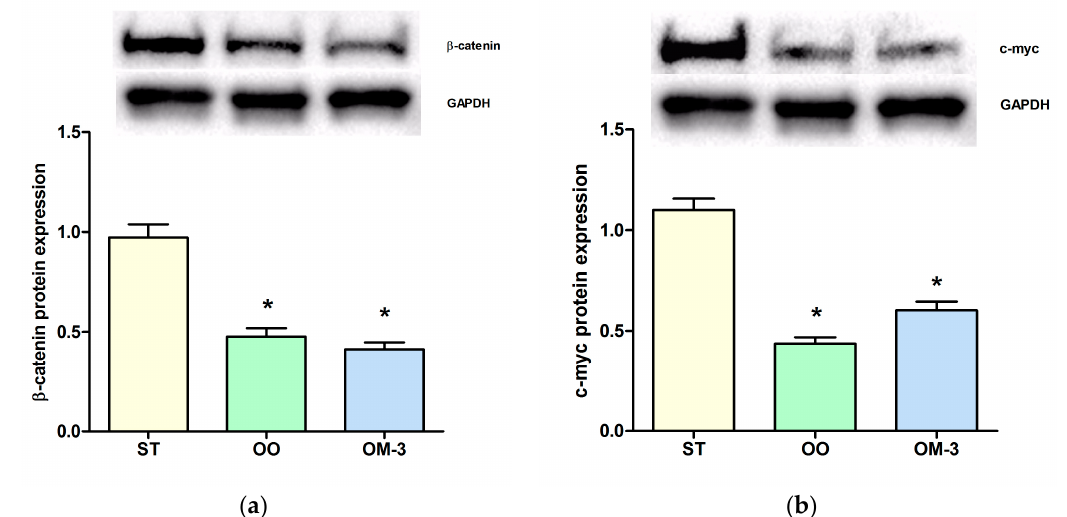
Figure 4. ( a ) western blotting analysis of expression of the β -catenin protein in intestinal tissue of treated Apc Min/+ mice; ( b ) western blotting analysis of expression of the c-myc protein in intestinal tissue of mice. ST = control group; OO = olive oil group; OM-3 = ω -3 PUFAs group. * p < 0.05 (ANOVA and Dunnett’s multiple comparison test, each experimental group vs. the ST group).